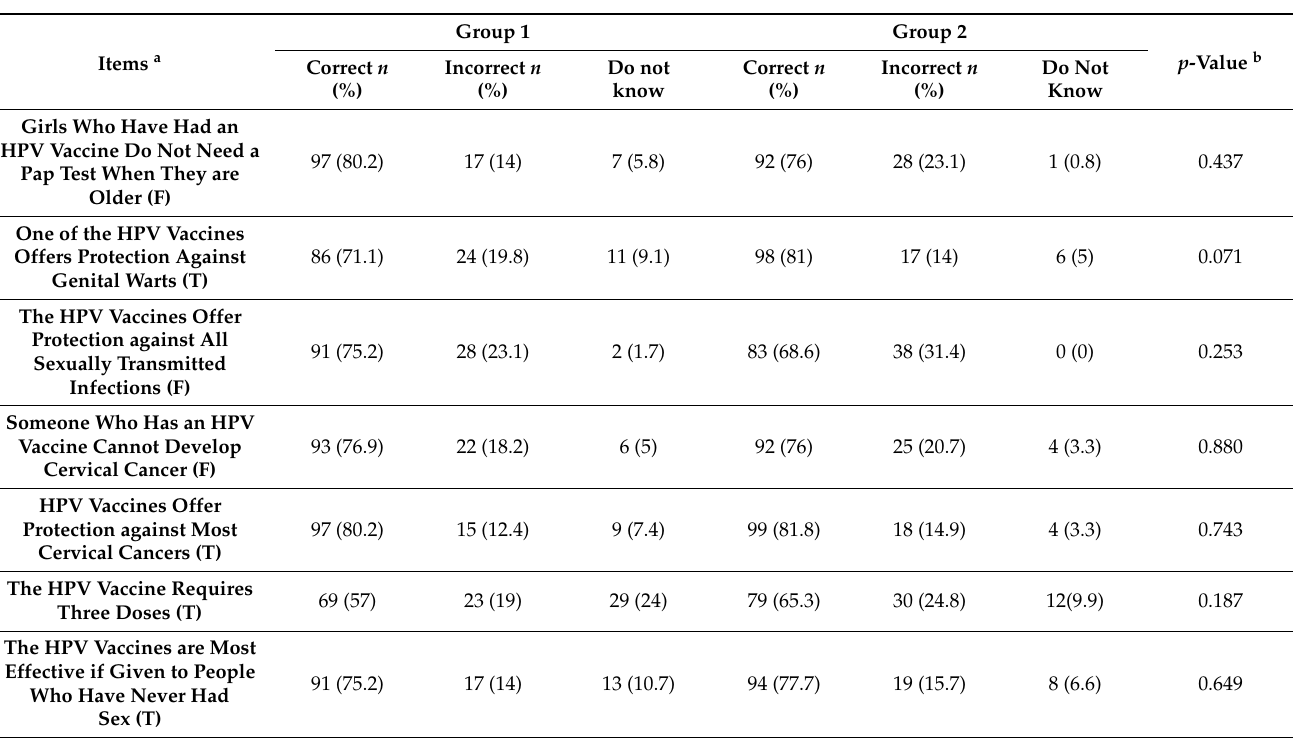
Table 5. Comparison of HPV vaccination knowledge after receiving the intervention between the two